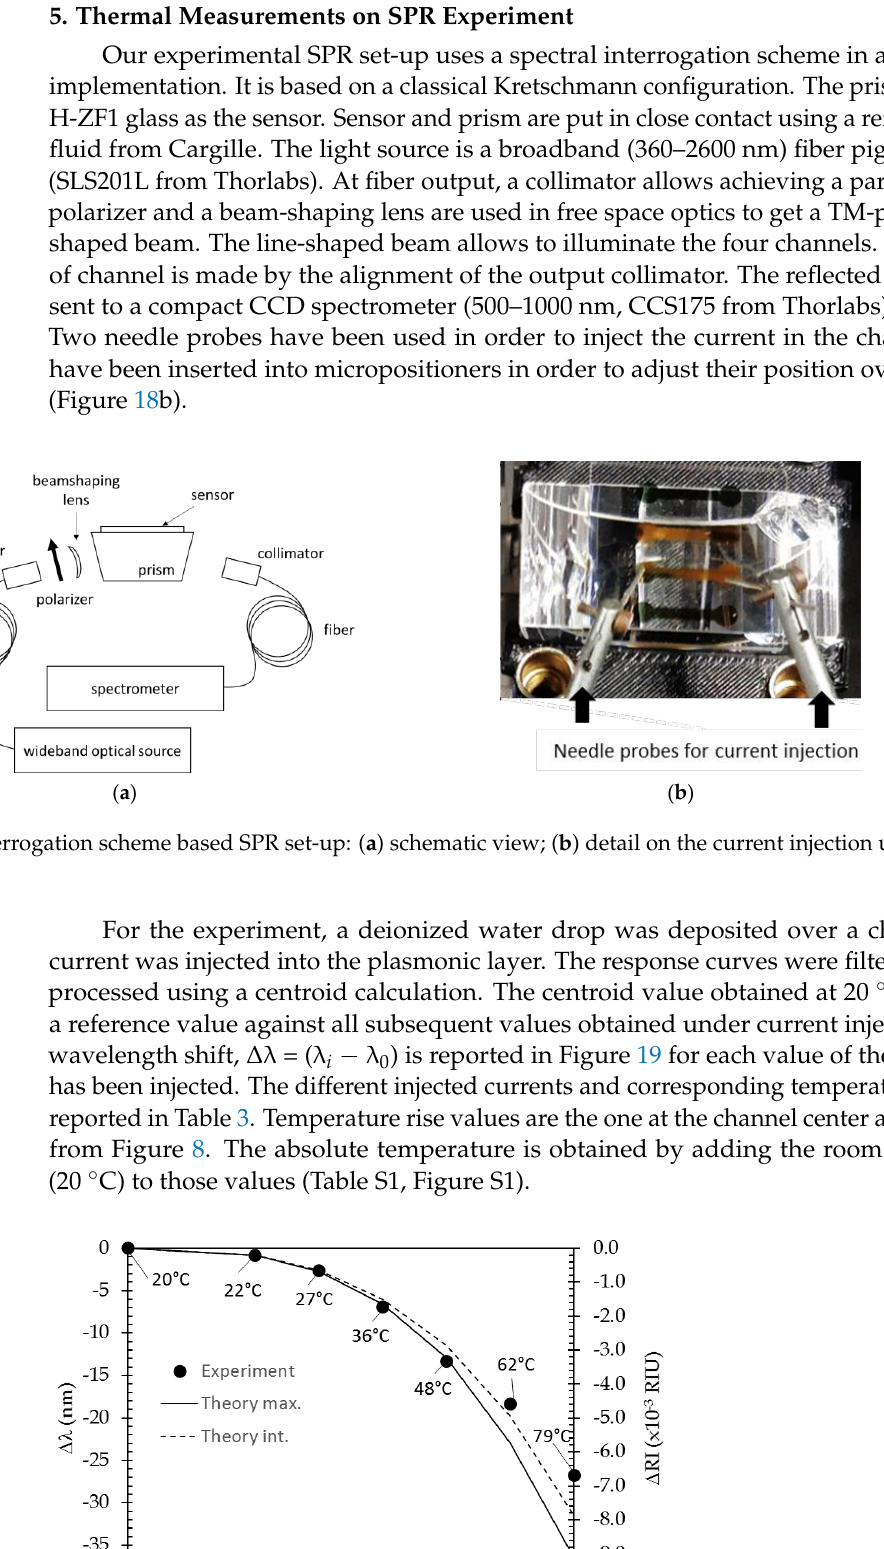
Figure 19. Wavelength shift versus the injected current.